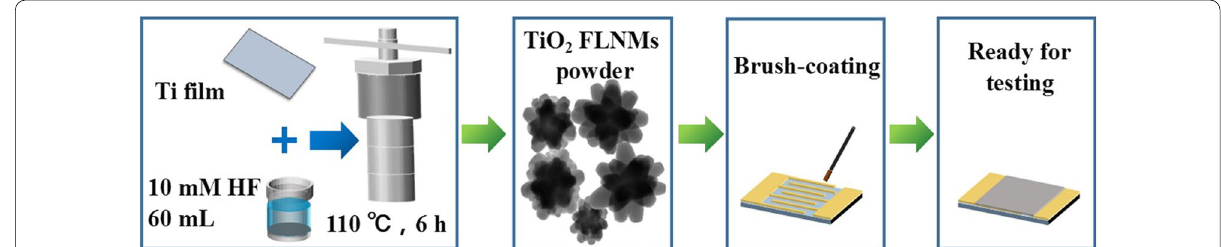
Fig. 1 The schematic diagram of TiO 2 FLNMs sensor preparation and